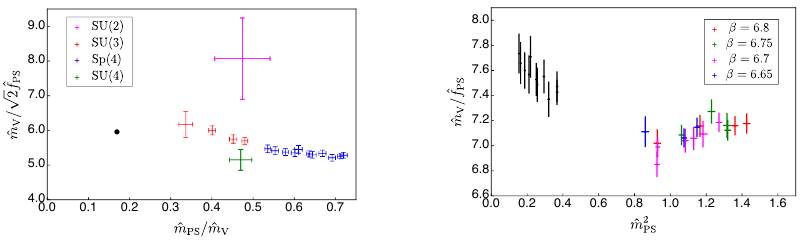
Figure 5. (left) Vector meson masses in various gauge theories with N f = 2 fundamental Dirac flavours: di ff erent colours are for various gauge groups, while the black dot denotes the QCD value. (right) Vector meson masses in Sp(4) theory with N f = 2 fundamental (in the continuum, black) and n f = 3 antisymmetric (colours for di ff erent β values) Dirac flavours. The hatted notation denotes the mass in units of the gradient flow scale, w 0 , e.g. ˆ m PS = m PS w 0 . Figures are taken from Refs. [8,